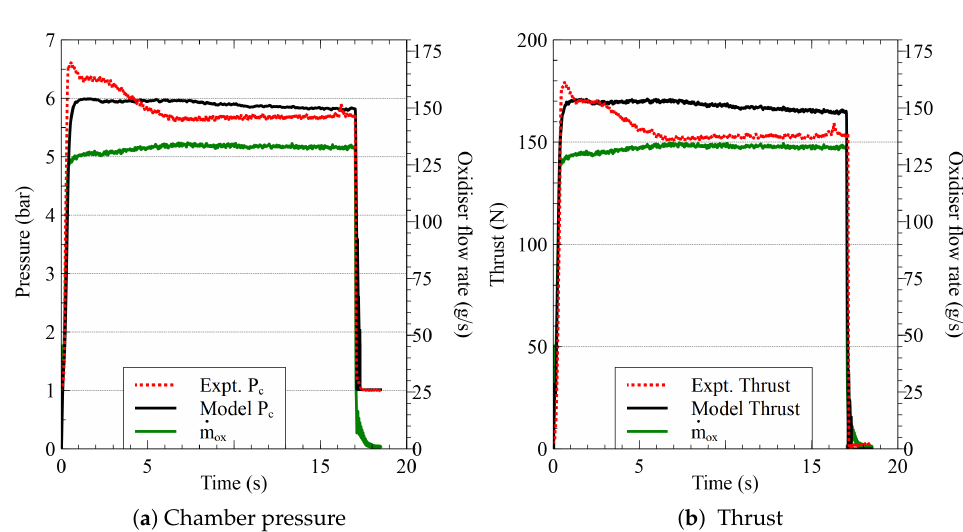
Figure 12. Comparison between experimental and numerical simulation results at a higher oxidizer mass flow